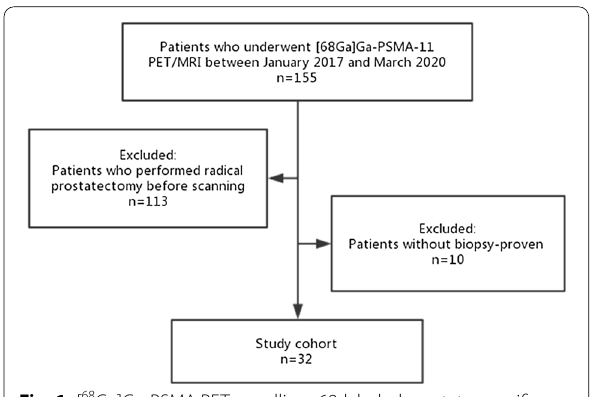
Fig. 1 [ 68 Ga]Ga-PSMA PET membrane antigen PET, mpMRI